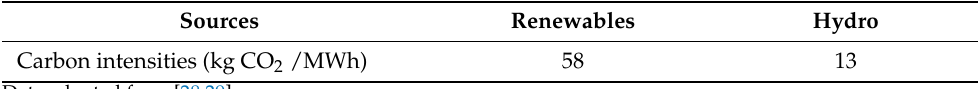
Table 3. China’s electricity CO 2 emission intensities of renewables. Sources Renewables Hydro Carbon intensities (kg CO 2 /MWh) 58 13 Data adapted from